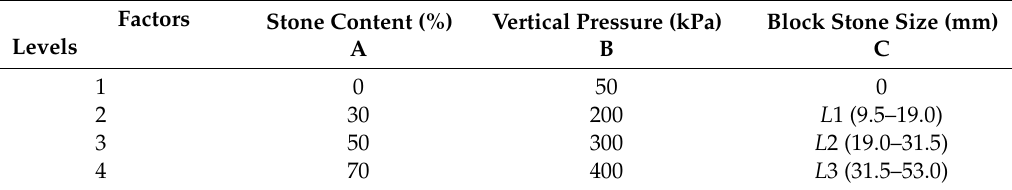
Table 3. Levels of factors for the range analysis.